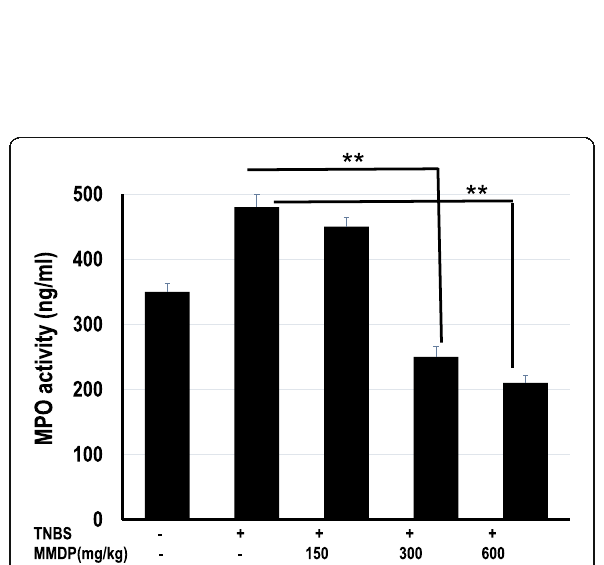
Fig. 4 Mango mistletoe Dendrophthoe pentandra (MMDP) extract reduced myeloperoxidase (MPO) levels in trinitrobenzene sulfonic acid (TNBS)-induced colitis mice. The activity of the MPO was assessed to evaluate infiltration of neutrophils. MPO levels were measured in lysed colon cells. MPO activity was assessed in the colon homogenates. Results shown are mean ± SD, with n = 6 replicates in each group . **, p <